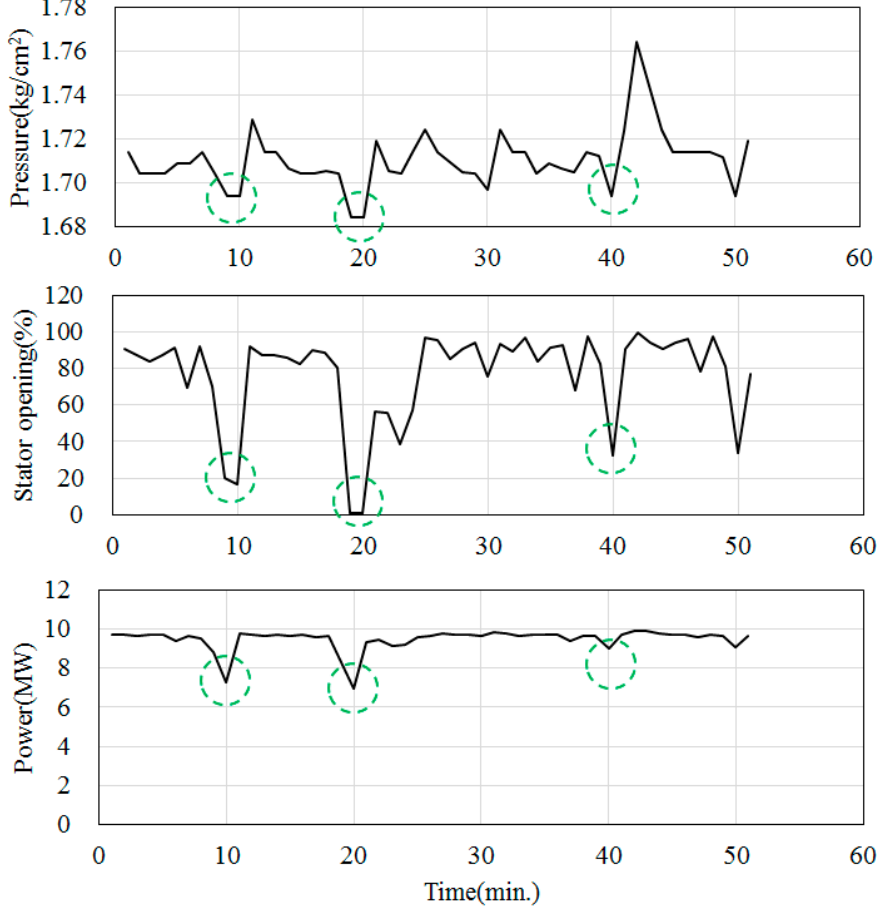
Figure 16. Operation conditions of inlet pressure, stationary blades’ opening, and power. Table 4. CFD analysis result .